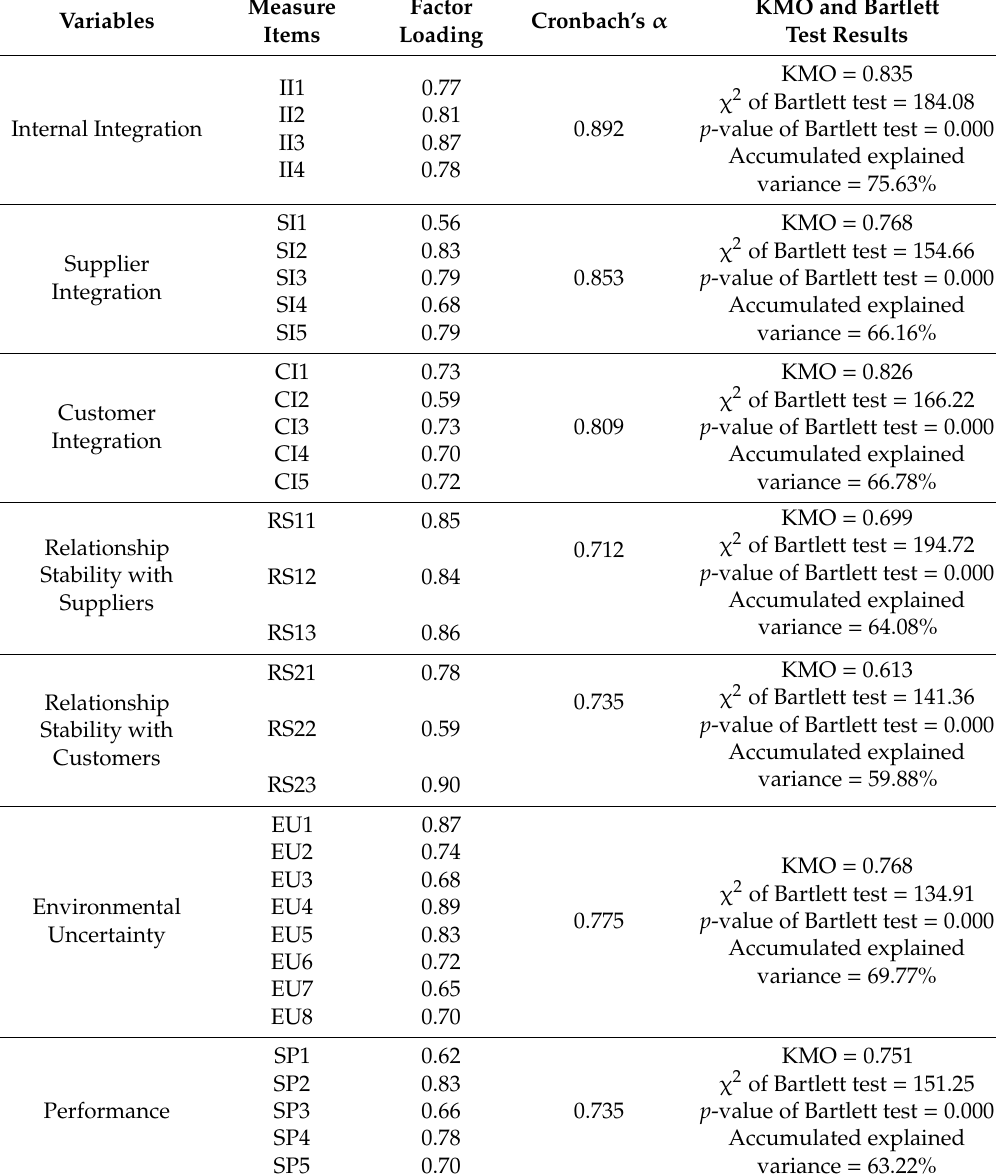
Table 3. Reliability and